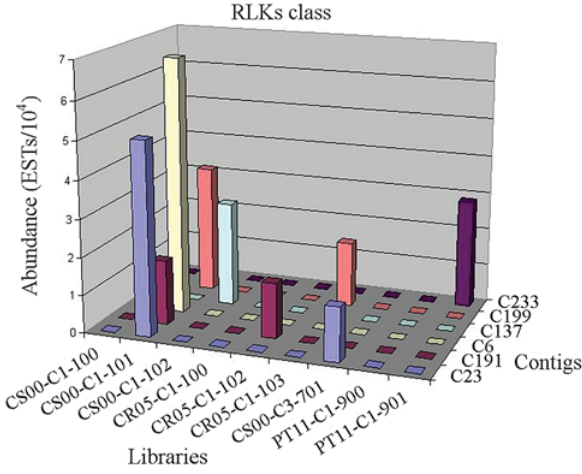
Figure 7 - Transformed data representing the relative abundance of EST by library, expressed in 10 4 reads, in contigs related to RLKs class. CS: Citrus sinensis ; CR: Citrus reticulata ; PT: Poncirus trifoliata ; C1: